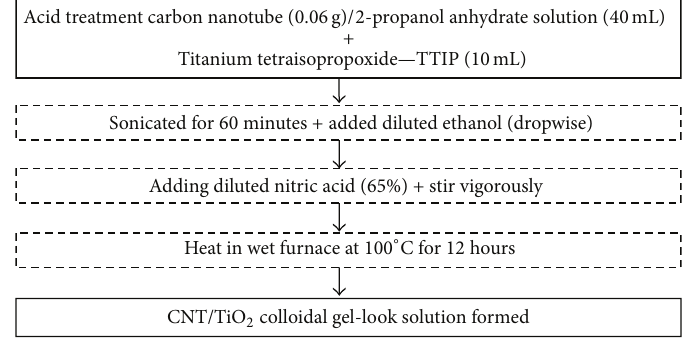
Figure 1: Flowchart for CNT/TiO 2 nanocomposite solution.